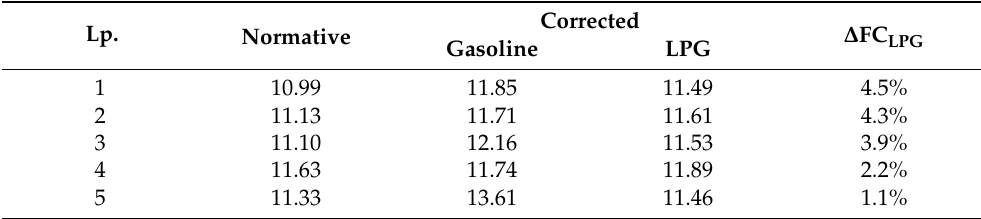
Table 9. Fuel consumption (dm 3 /100 km) in Low phase of WLTC cycle, calculated by both normative and corrected